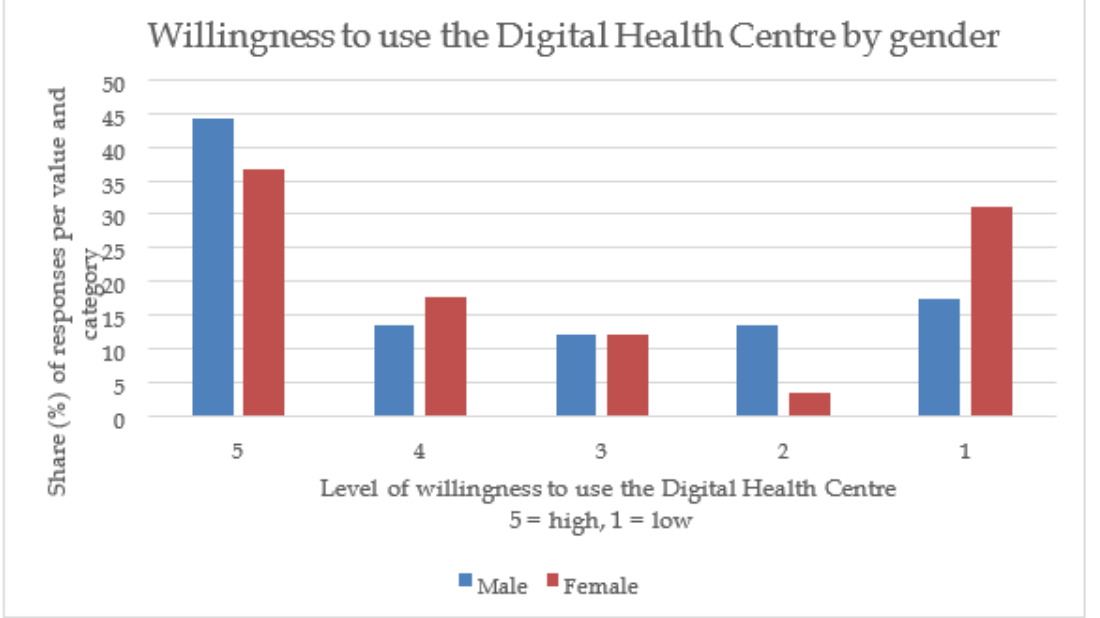
Figure 15. Willingness to use the Digital Health Centre and gender. Percentage per reported value on scale 5-1. Male n=134 (100%); Female n=126 (100%). Total n=260.